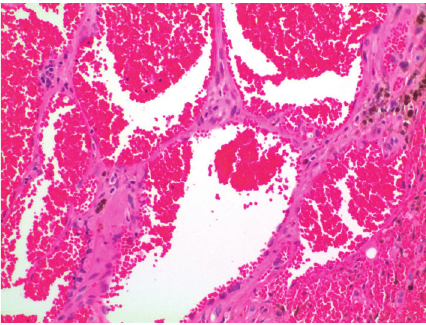
Figure 4: A well-circumscribed area of high grade angiosarcoma. The tumor cells are large and polygonal with abundant cytoplasm,